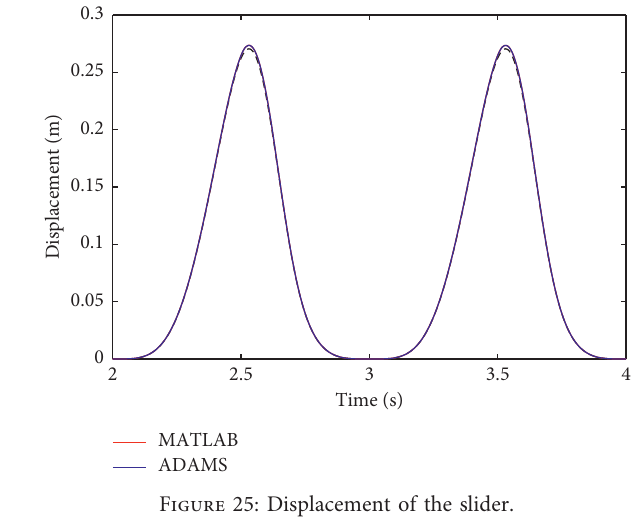
Figure 25: Displacement of the slider.